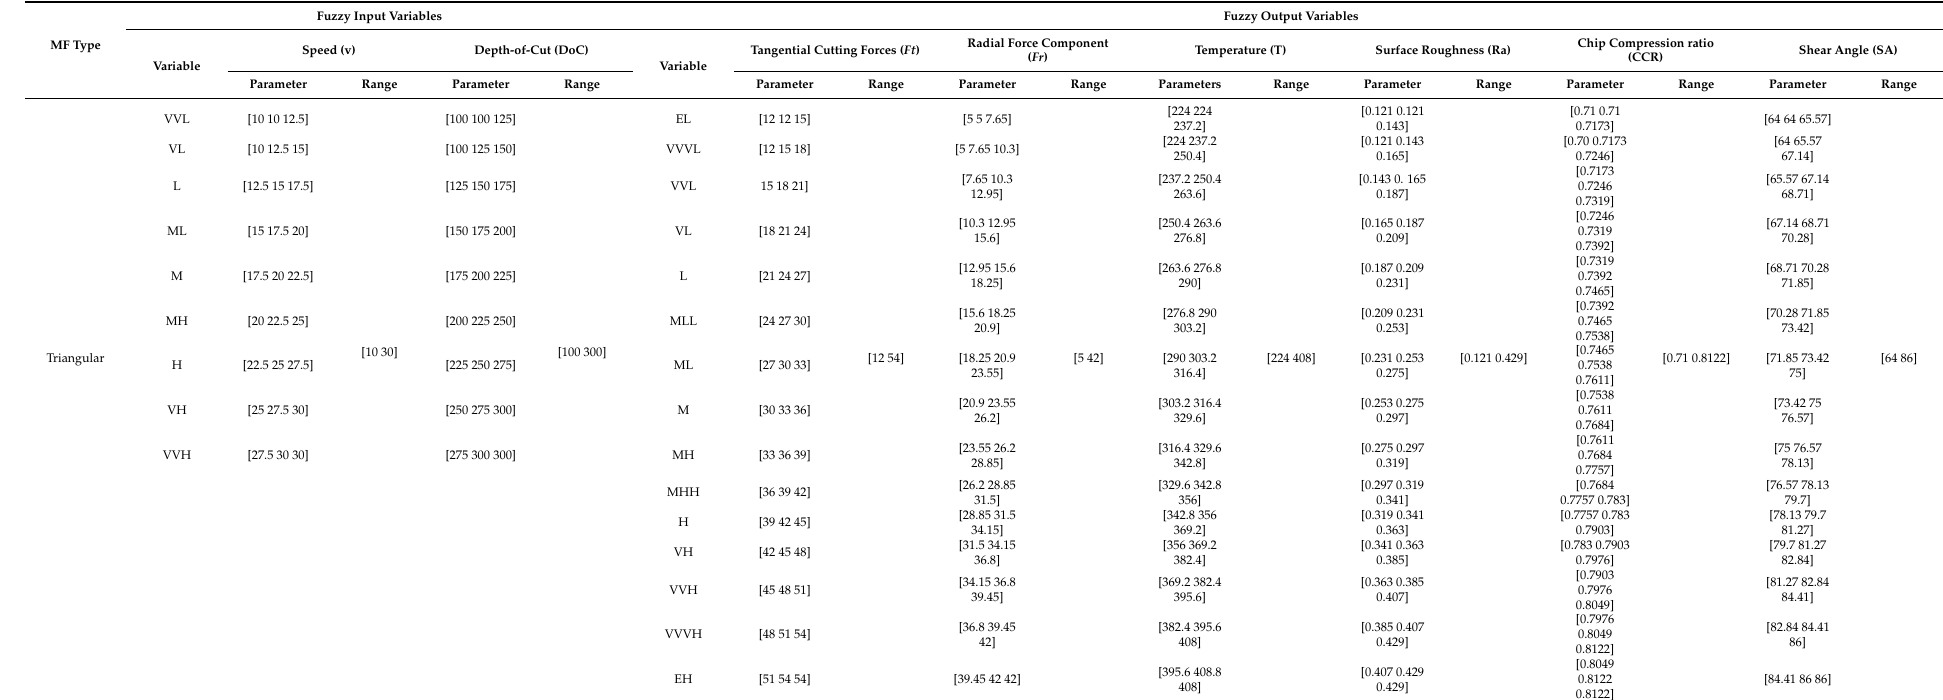
Table 3. Input and output parameters used in the UVAT fuzzy inference